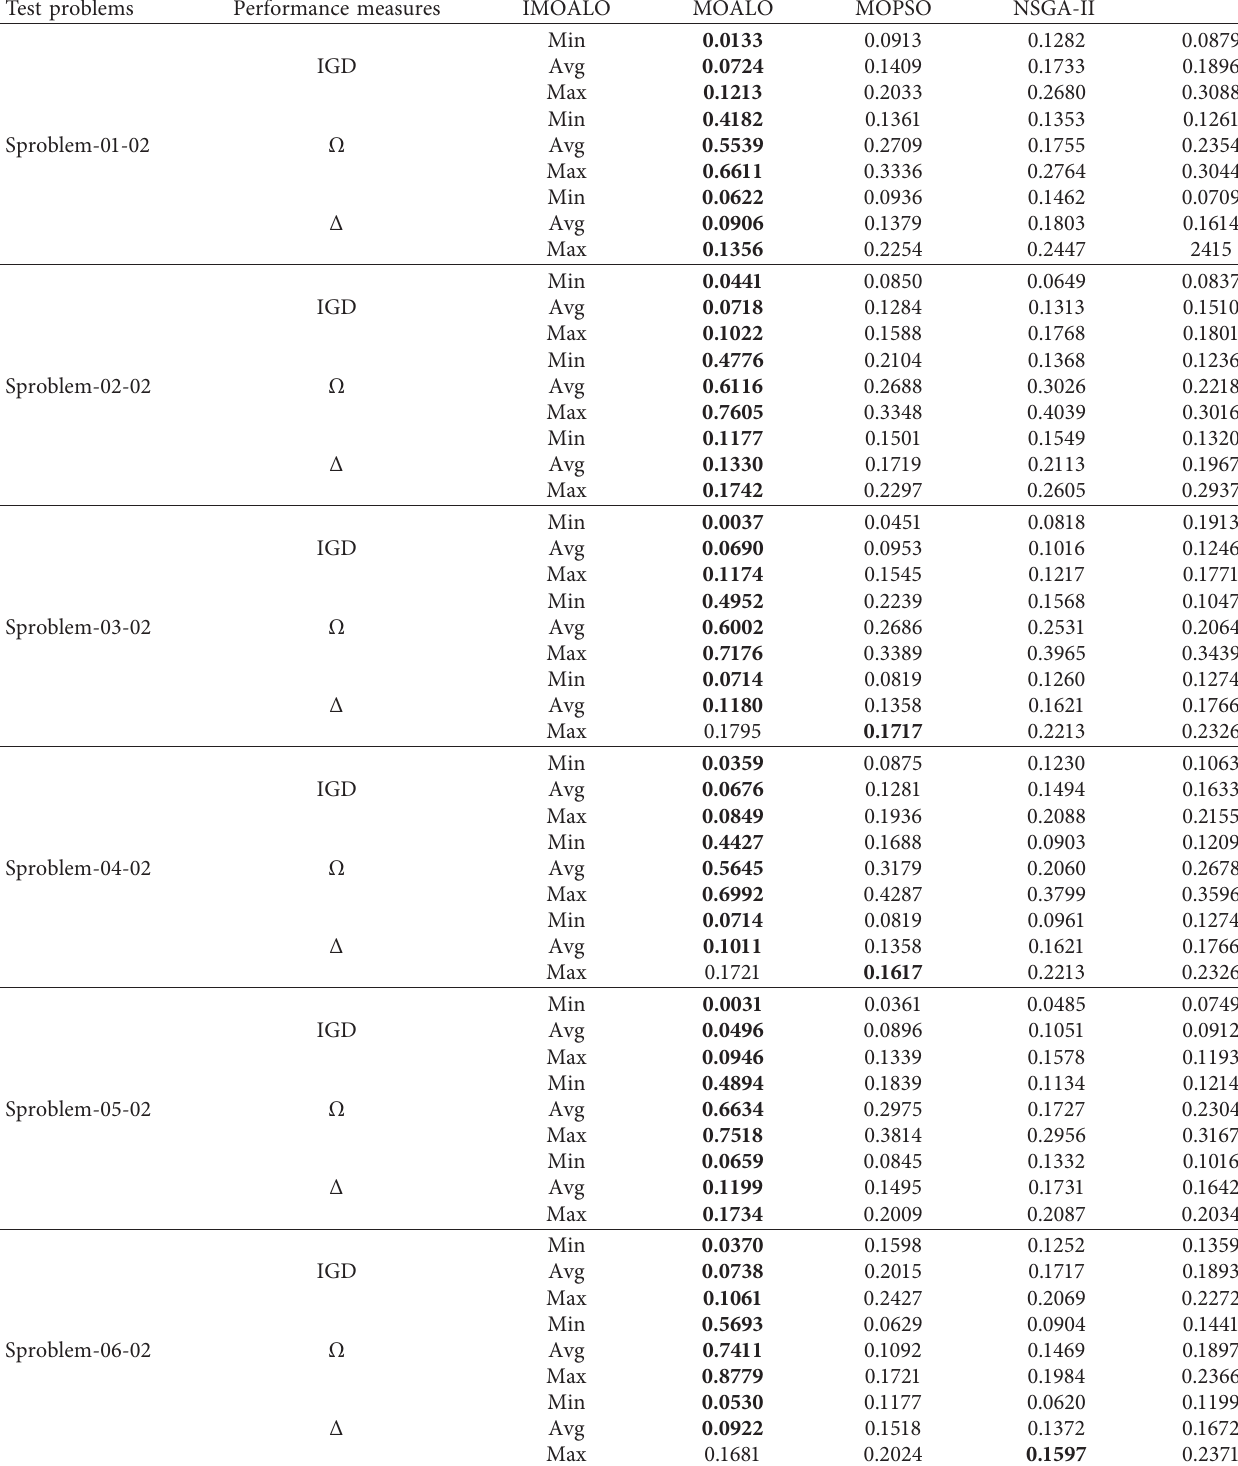
Table 4: Comparisons of four algorithms for six test